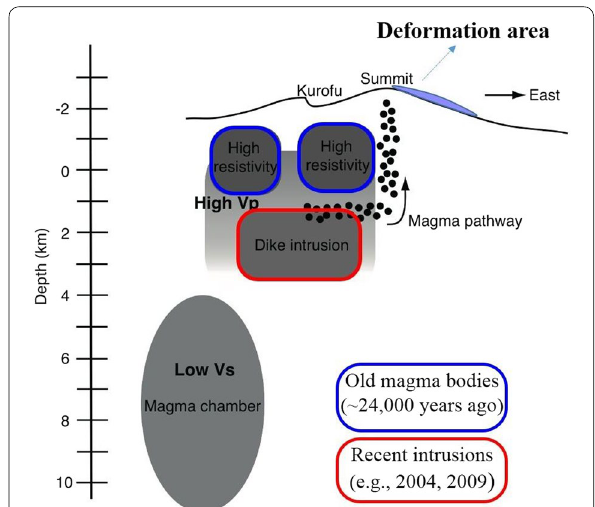
Fig. 12 A schematic view of potential magma pathway at Asama volcano inferred from geodetic and seismic studies. The black dots indicate the earthquake swarms recorded in the 2004 eruption (modified from Aoki et al.